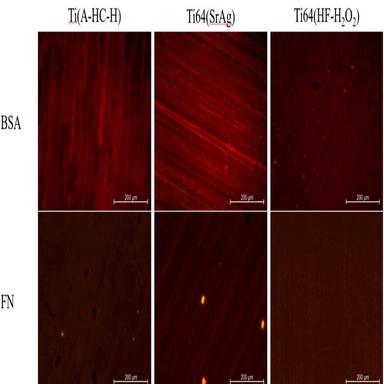
Fluorescent images of rhodamine-conjugated albumin and fibronectin adsorbed on the different surfaces (200x).